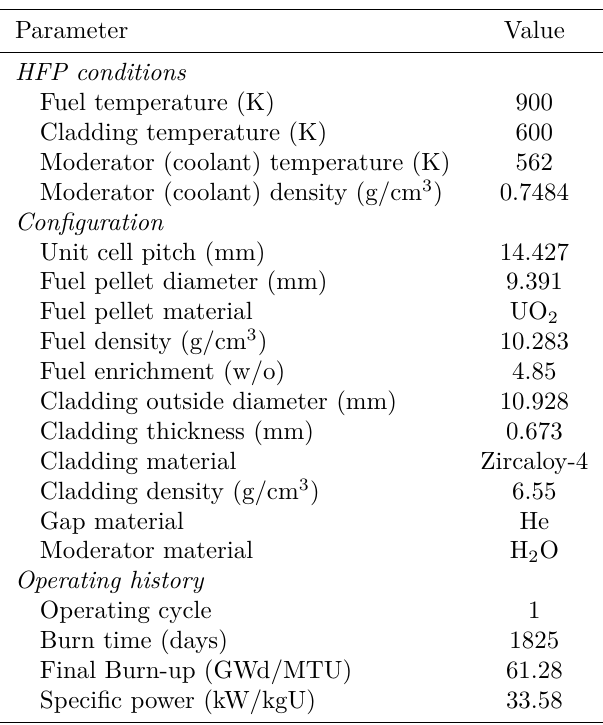
Table 1. Configuration and conditions of burnup pin-cell test problem.